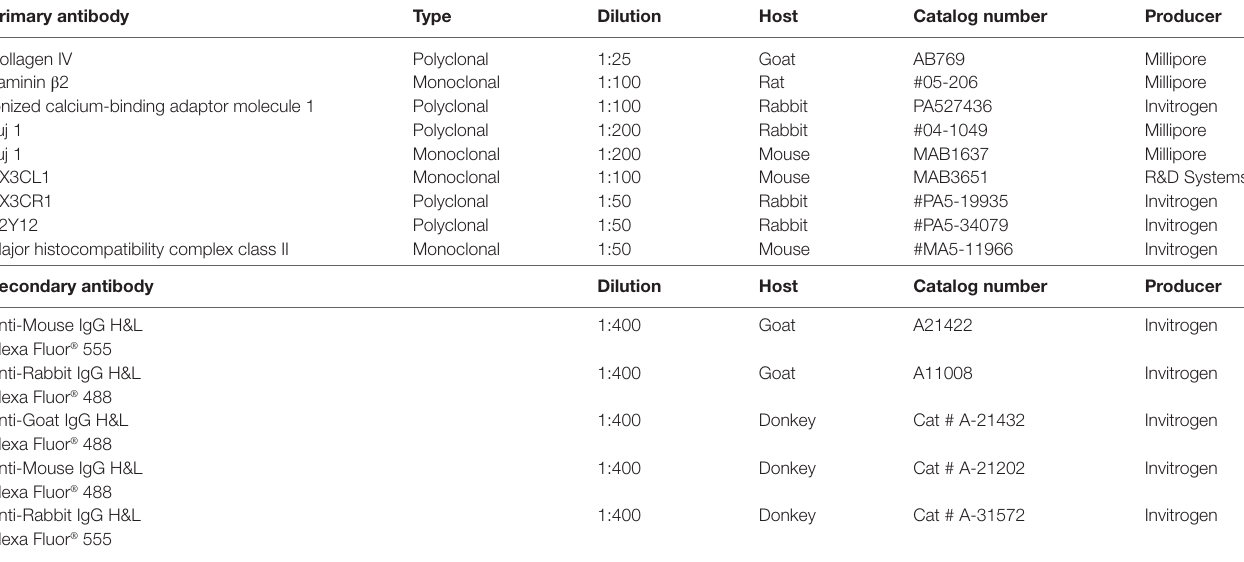
Table 2 | Antibodies used in the study. Primary